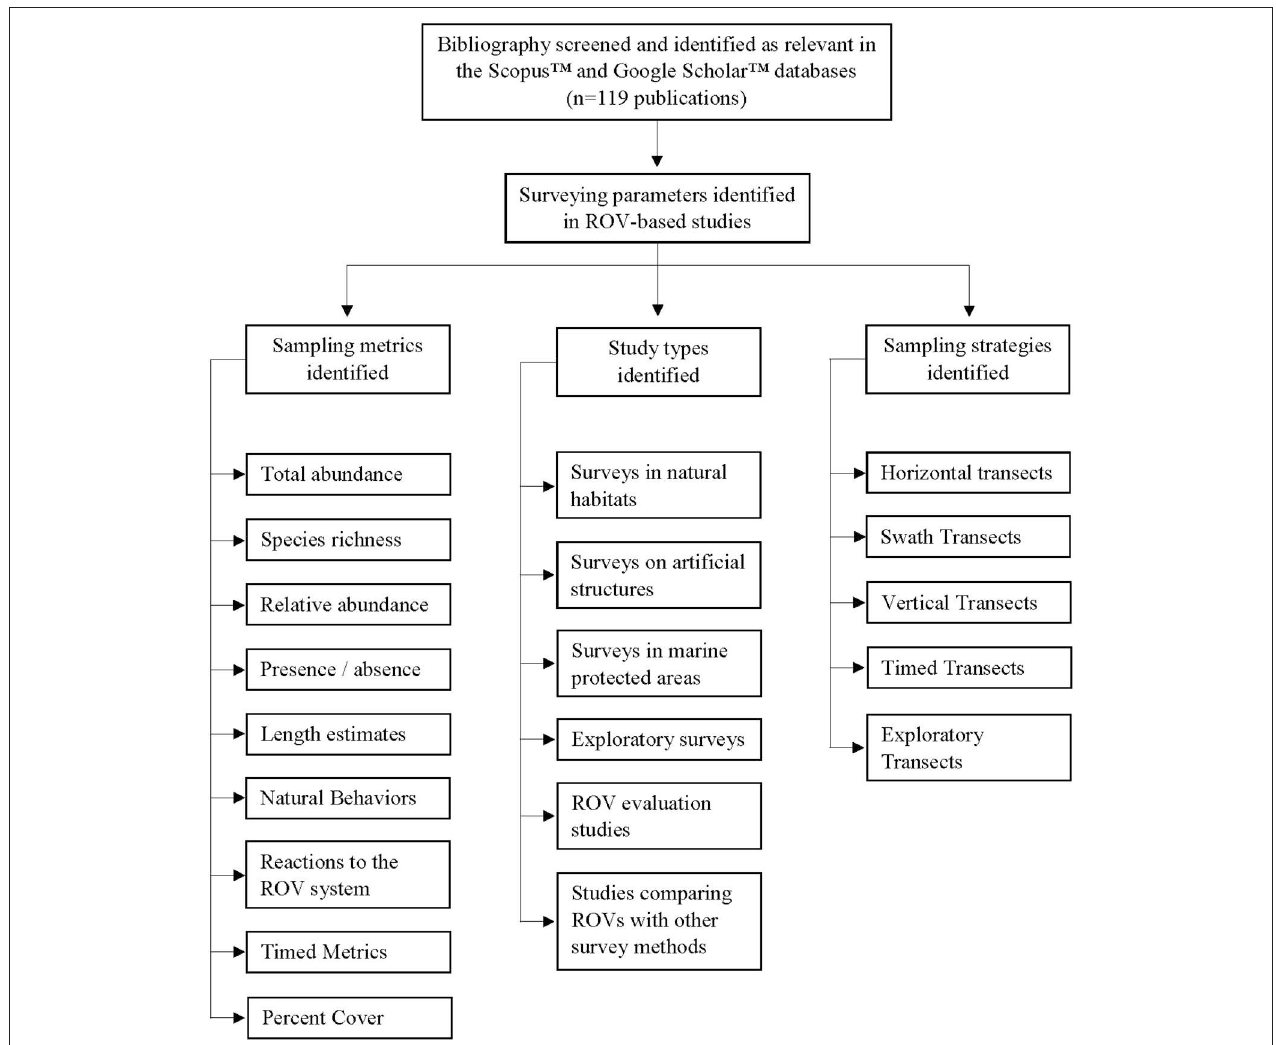
FIGURE 1 | The sampling parameters identified for visual-based ROV surveys of fish assemblages.